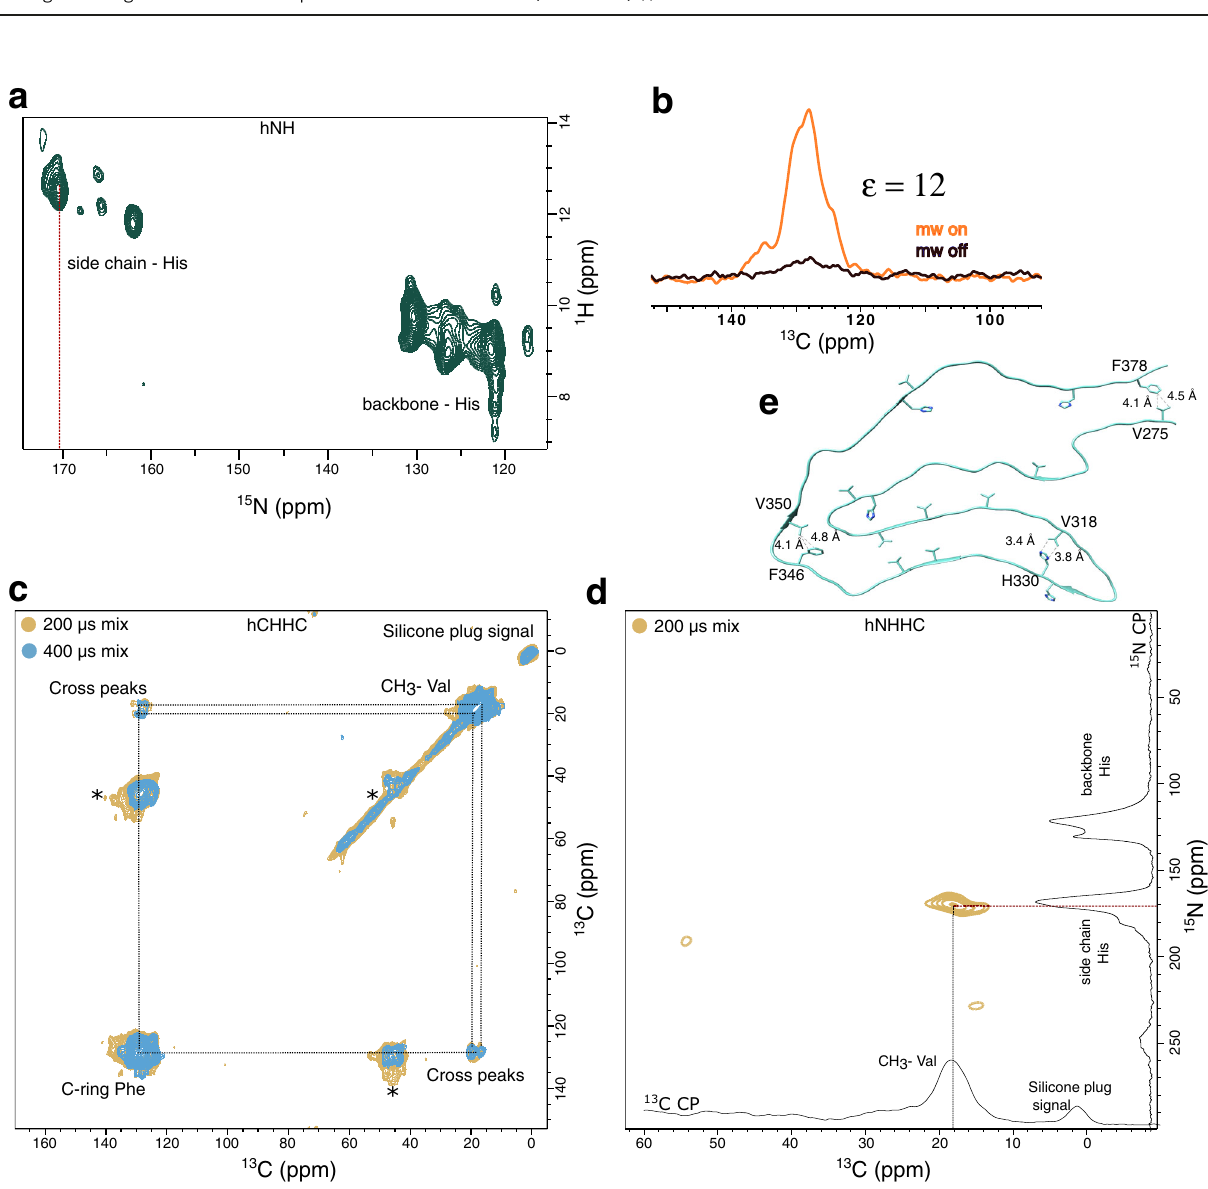
Fig. 3 Solid-state NMR of the core of heparin-free tau fi brils. a 13 C- 13 C RFDR spectra of 2N4R tau fi brils (middle panel), which were aggregated without (orange) or with heparin (black). The C β region of serine and threonine residues is highlighted on the left, the C γ region of threonine to the right. b Amino acid sequence of the repeat region of 2N4R tau. Serine residues are colored in green, threonine residues in red. The core of heparin-free 2N4R tau fi brils is highlighted in orange. The fi brillar core of heparin-induced 2N4R tau fi brils is underlined with black dashed lines. c Number of serine and threonine residues in the core of 2N4R tau fi brils that were formed in the absence or presence of heparin (according to ( b )). d , Strips from 3D NCACX (blue) and 3D NCOCX (green) spectra of heparin-free 2N4R tau fi brils, illustrating the sequential assignment of residues. e Selected region of the 13 C- 13 C RFDR spectrum of heparin-free 2N4R tau fi brils, indicating the assignment of the cross peaks of residues S305 and V306. f 2D NCA spectrum of heparin-free 2N4R tau fi brils, indicating the assignment of the cross peaks of residues 303-306 (based on ( d )).